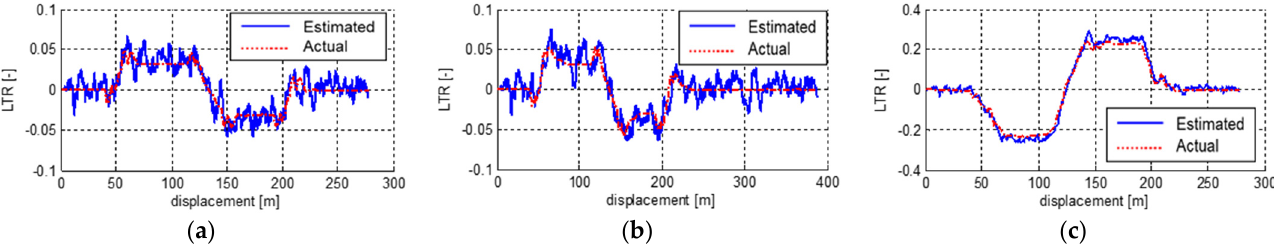
Figure 6. Estimated LTR using lateral acceleration and actual LTR in banked road condition. ( a , b ) refer to the straight road with the bank angle condition, and ( c ) refers to the S-curve with the road bank angle condition.